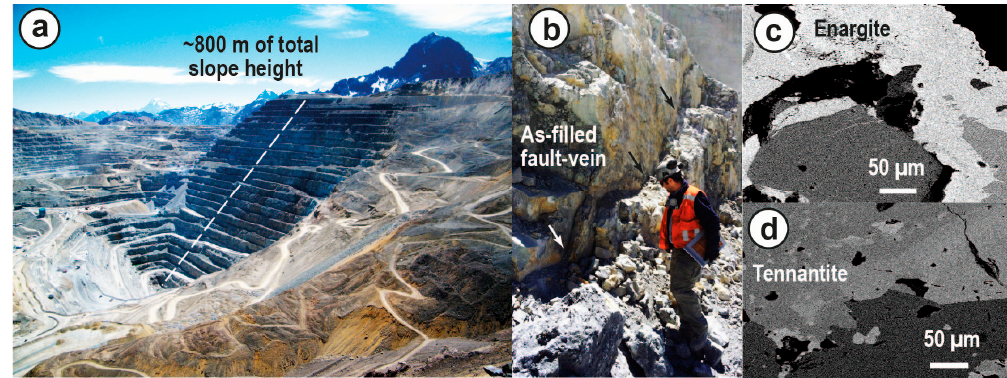
Figure 3. ( a ) Photograph of the Los Bronces open pit. ( b ) Photograph of an outcrop showing a principal fault-vein filled by the As -bearing minerals. Scanning electron microscopy (SEM)-backscattered electron (BSE) images of an enargite ( c ) and a tennantite ( d ) crystal.